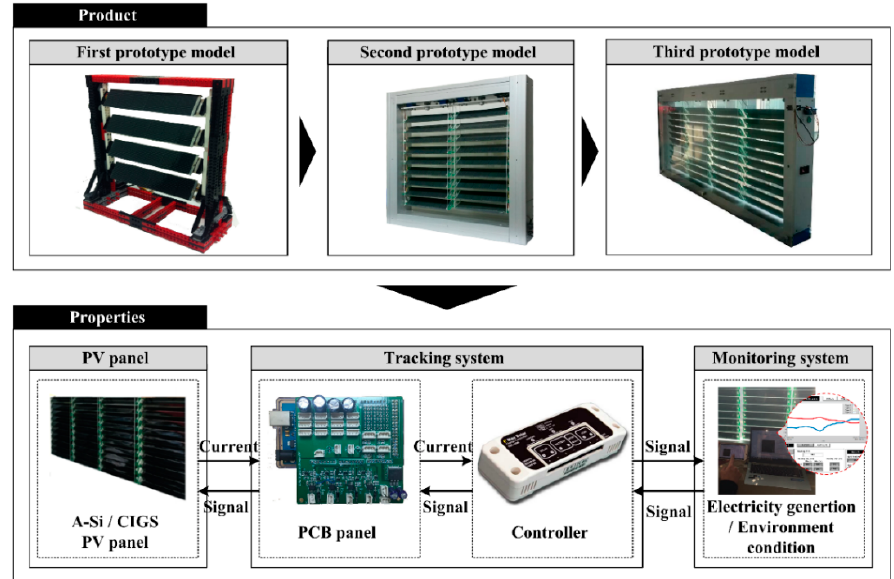
Figure 3. The prototype models of the SPSB and the associated properties. Table 3. Characteristic by the prototype model of the